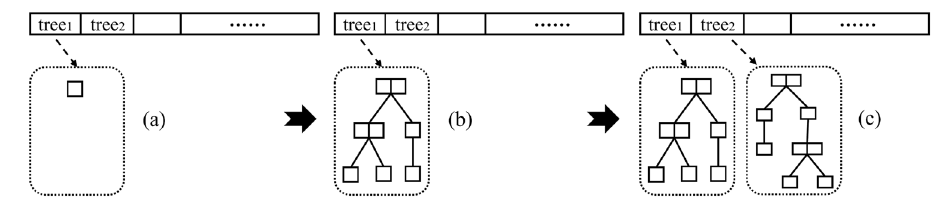
Fig. 7 Search for trips con- sidering both time and spatial